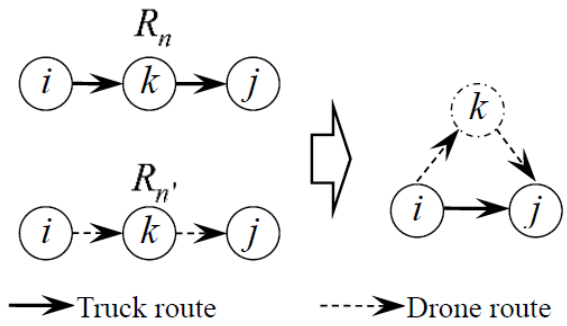
Figure 2. Route update.